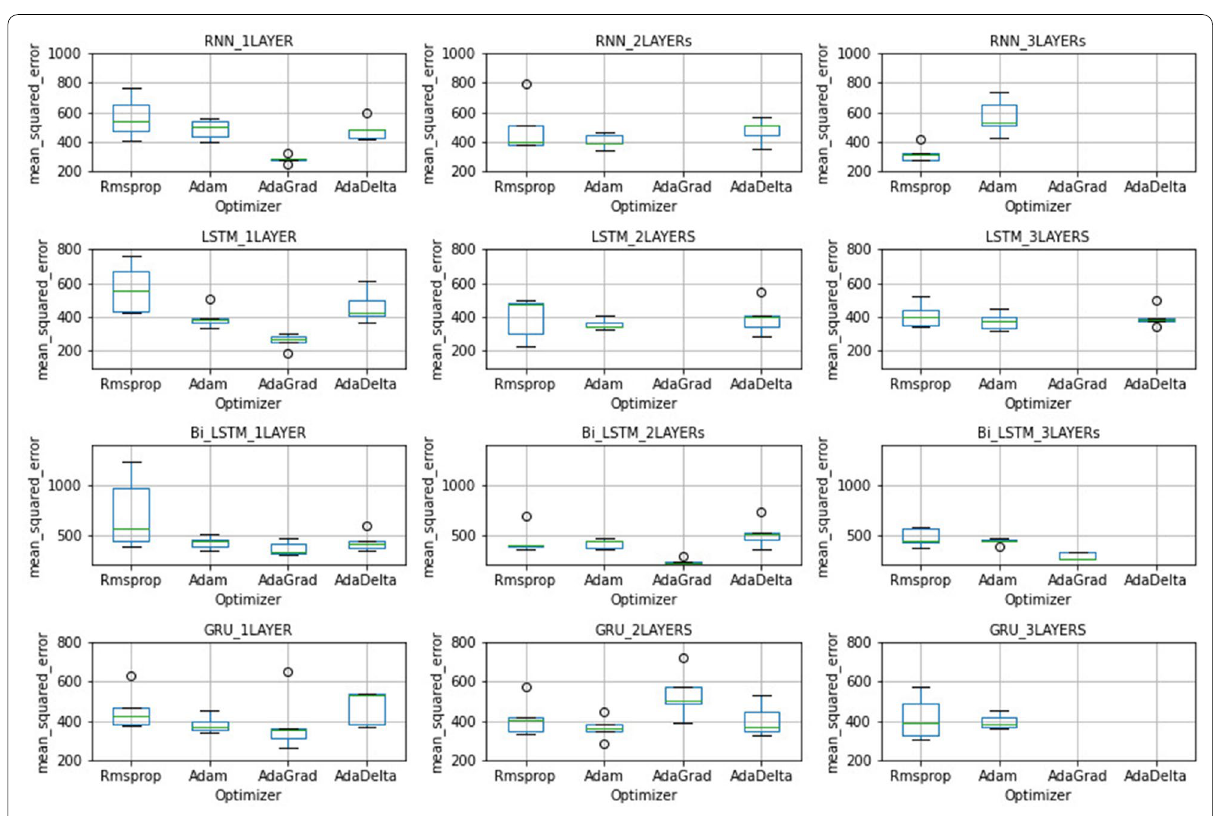
Figure 6 Performance of different optimizers on the testing dataset